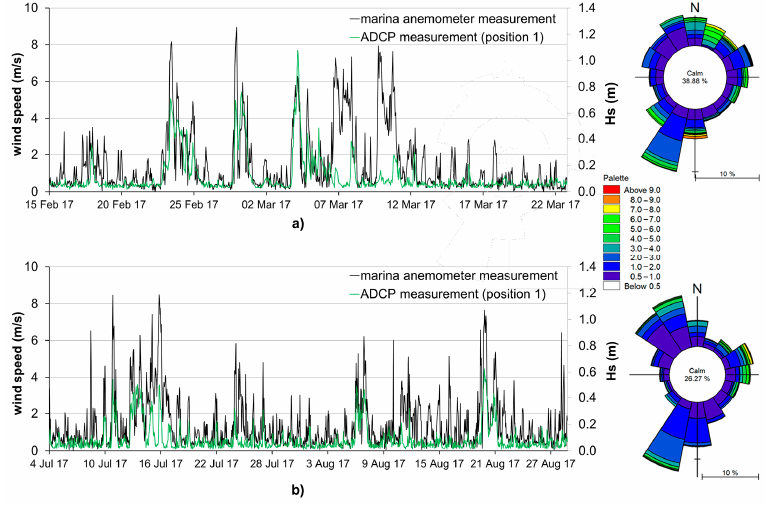
Figure 5. Time series of wind velocities and significant wave heights (measured at position 1, hourly averaged) with the corresponding wind rose for the ( a ) winter and ( b ) summer measurement periods. The incident wind waves approaching the marina in a band from 90° (E) to 180° (S) provide the most intense culvert inflow (marked by red line in Figure 6). During the winter and summer measurement periods, noteworthy wave situations were documented (Tables 2 and 3) assuming the criteria: H S ≥ 0.3 m, T P ≥ 2.8 s and incident wave direction in the band from 90° (E) to 180° (S), measured